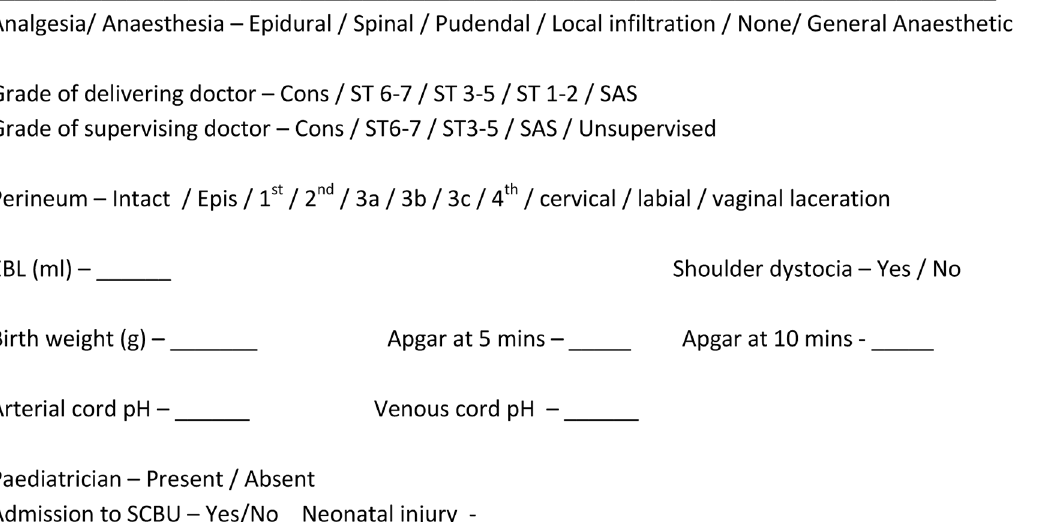
Fig 2. A Sample standard operative rotation vaginal delivery documentation template. Proposed documentation proforma to record essentialdata that can be used in all operativemethods to expedite deliveryin second stage labours complicatedwith fetal